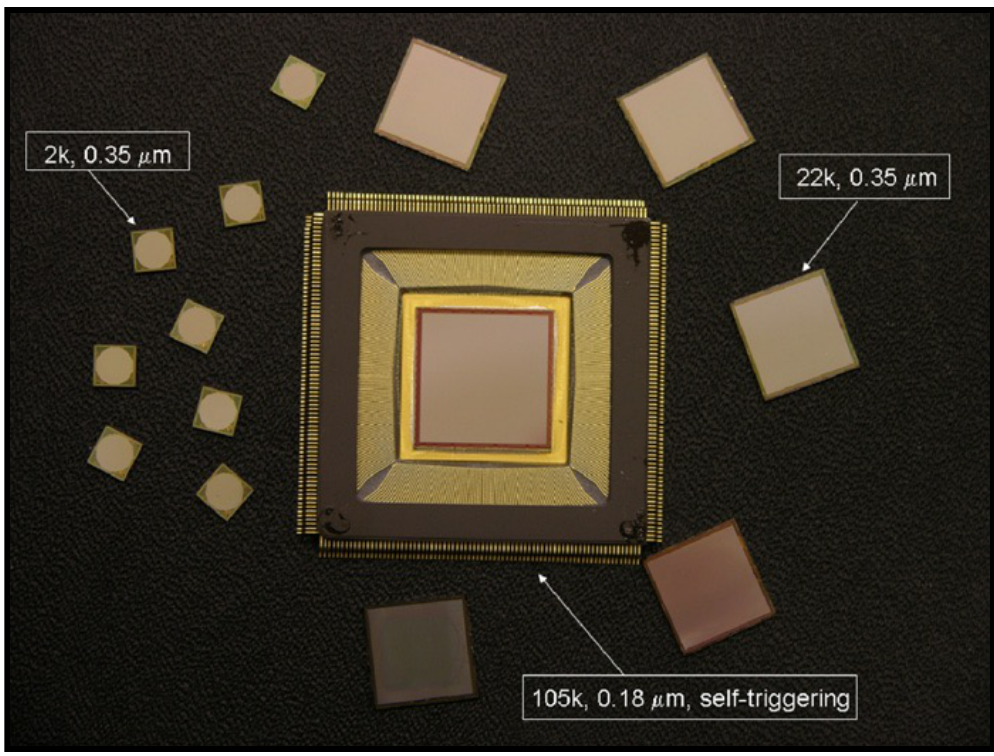
Figure 3. The comparison of the three generations of ASIC chips, developed by the Pisa group, starting from 2000 to arrive to more than 100,000 pixels. The chip of 105 k pixels is shown bonded to its keramic package